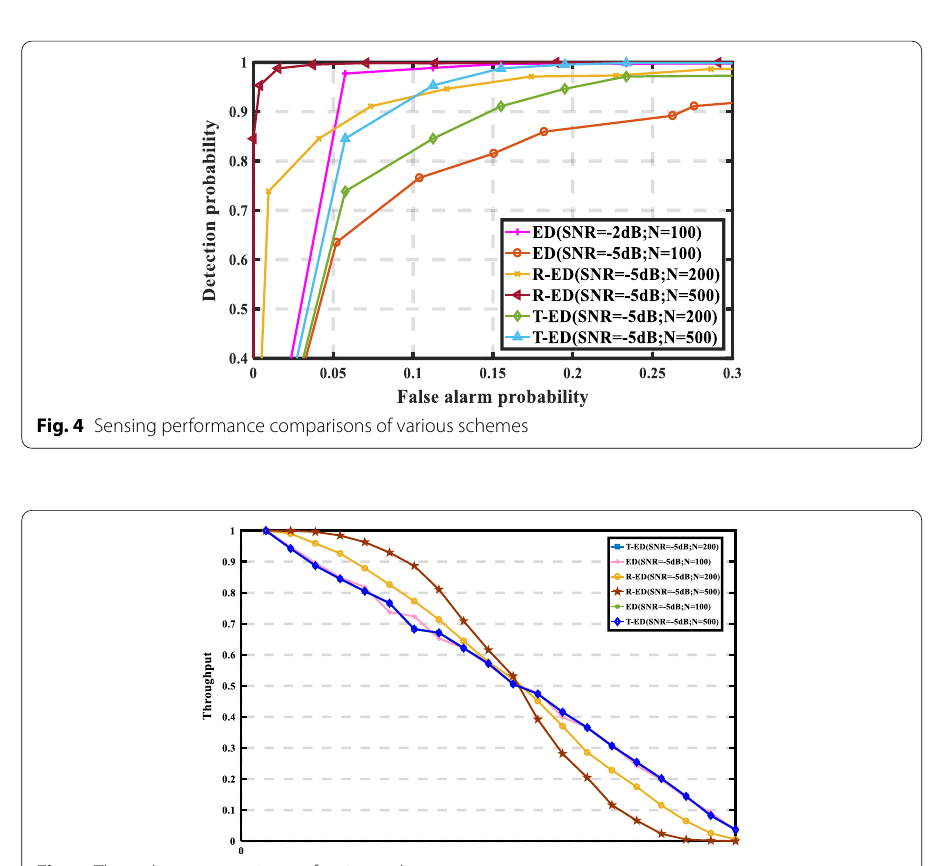
Fig. 5 Throughput comparisons of various